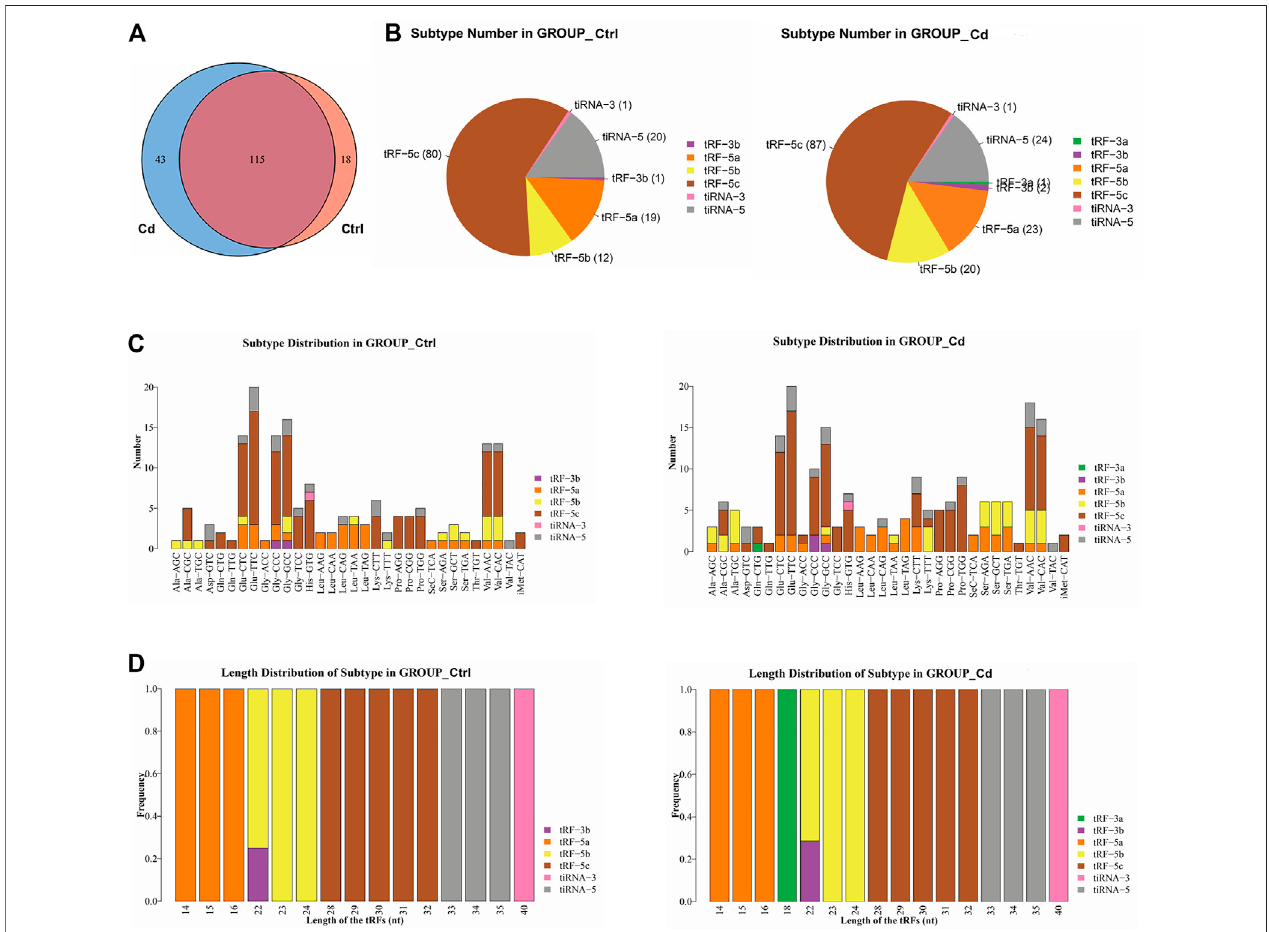
FIGURE 2 | Effects of Cd exposure on sperm tsRNAs expression pro fi le. (A) Venn diagram of the number of tsRNAs. The pie plot shows the number of tsRNAs which were expressed in both of the groups and also the number of speci fi c expressed tsRNAs in Ctrl or Cd group. (B) Pie charts for all tsRNAs of each group using all uniquelyexpressed tsRNAs.ThepiechartshowthedistributionofthenumberforeachsubtypetsRNAswhichtheaverageCPMofthegroupisnotlessthan20. (C) The stacked bar charts stack bars that represent different tRNA isodecoders on top of each other, respectively. The height of the resulting bar shows the combined resultoftRNAisodecoders. (D) Thestackedbarchartsrepresentthelengthdistribution oftsRNAsubtypeforeachgroup.CPM:countspermillionoftotalalignedreads.